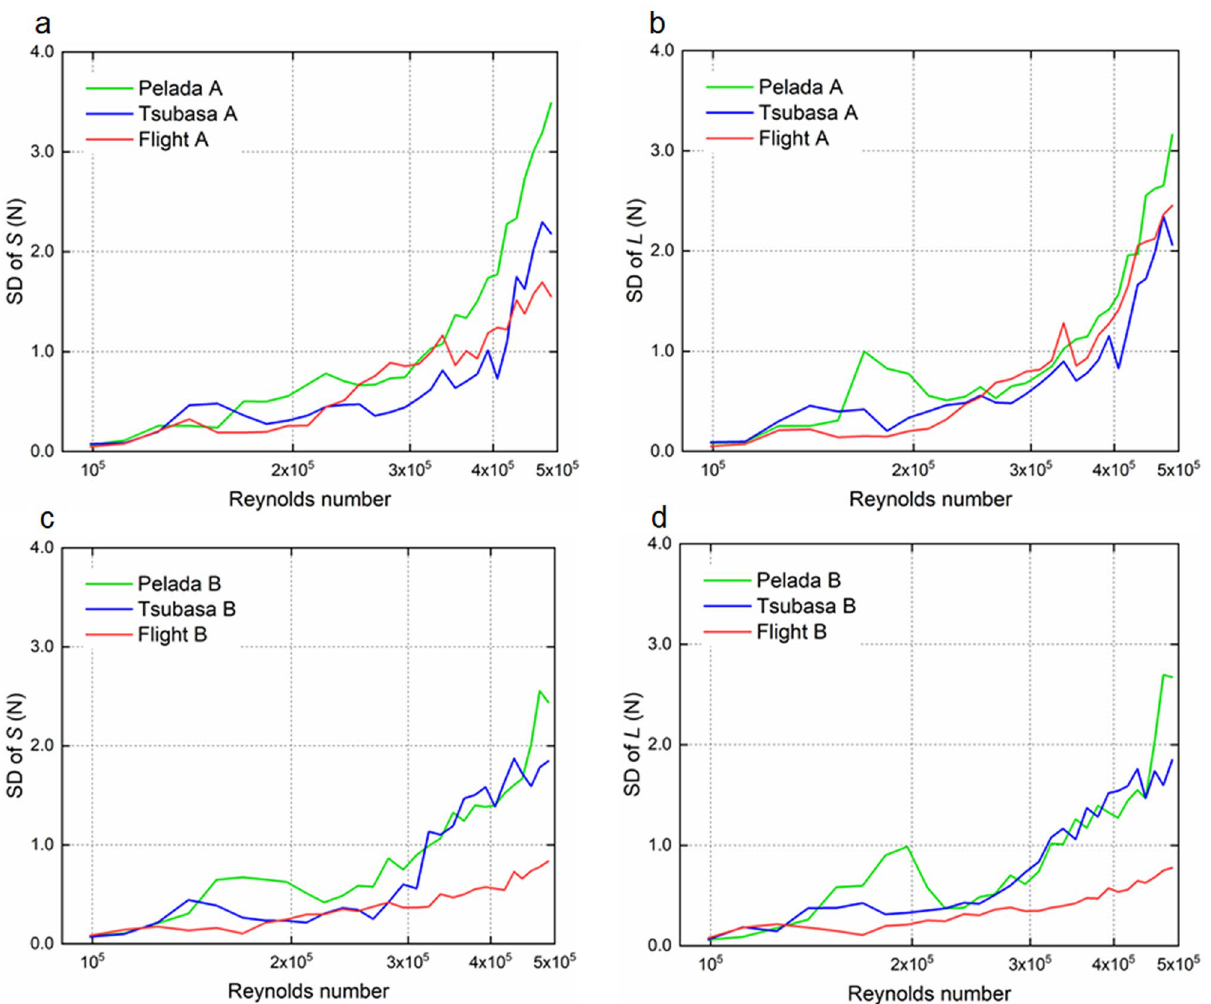
Figure 7. Standard deviation (SD) of the side ( S ) and lift ( L ) forces for Flight 2020, Tsubasa 2020, and Pelada 2020: ( a , b ) symmetric and ( c , d ) asymmetric